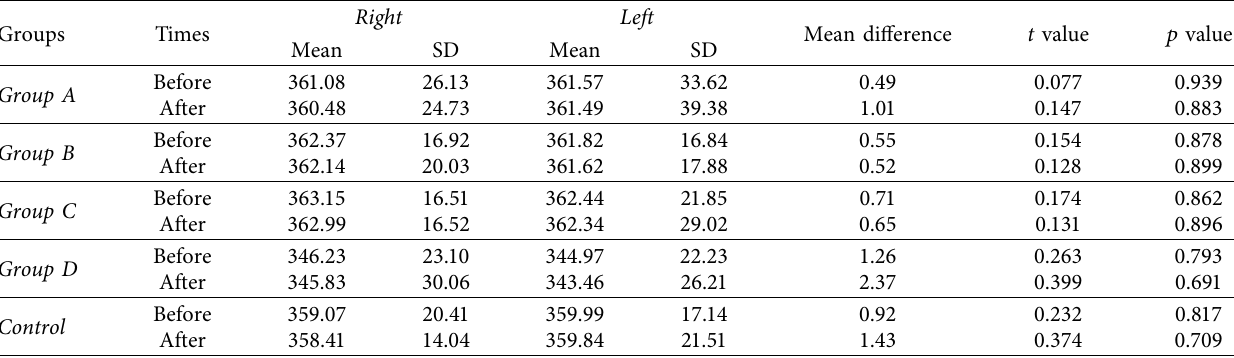
Table 10: Sidewise comparison of masseter muscle